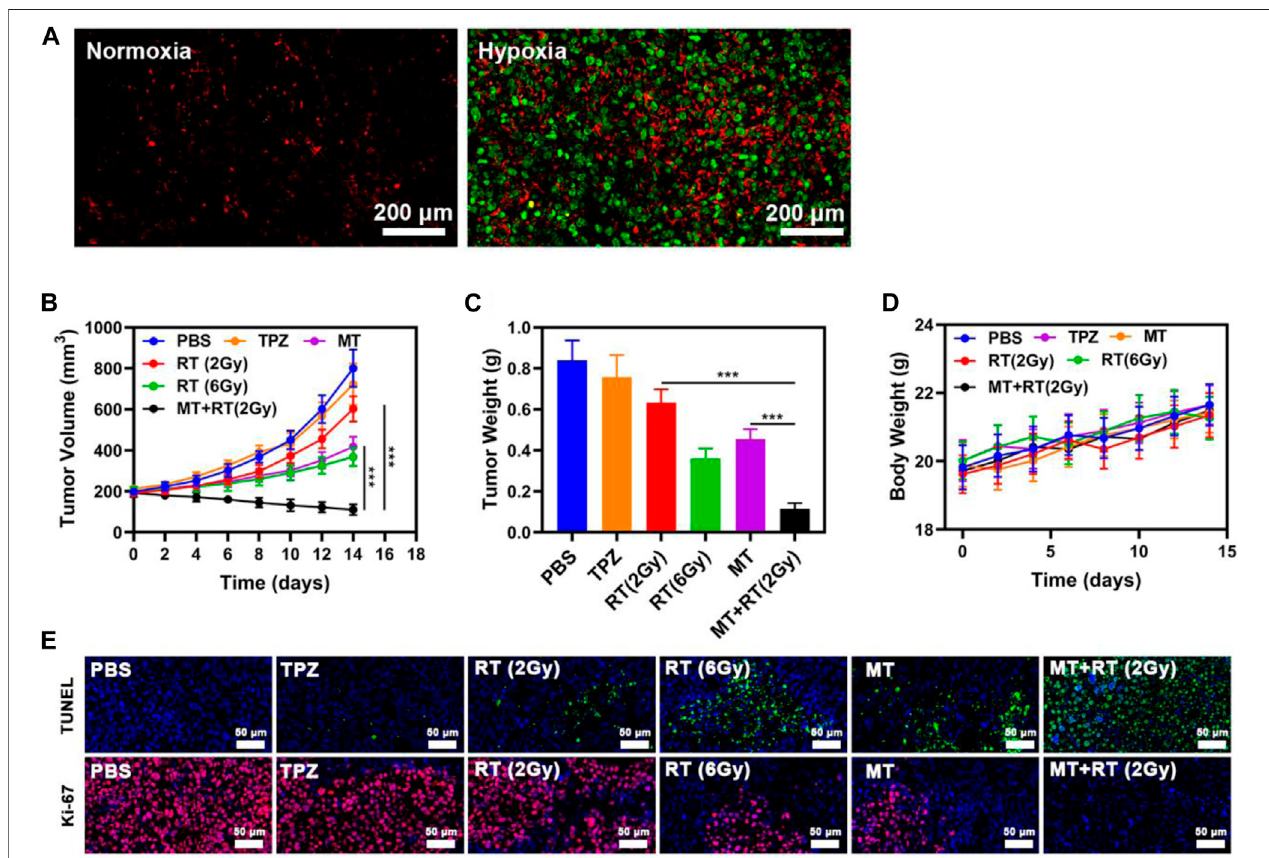
FIGURE 3 | (A) Assessment of the colocalization between MT and intratumoral hypoxia (Green: PIMO, red: DiL labeled MT). (B) Tumor volume, (C) tumor weight, and (D) body weight in the indicated treatment groups as assessed over time ( n (cid:2) 5). (E) Tumor sections following TUNEL or Ki-67 staining. *p < 0.05, **p < 0.01, ***p < 0.001; Student ’ s t